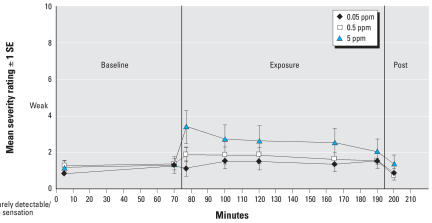
Mean anxiety symptom severity at each time point across exposure conditions. Post, postexposure. Change from 70 min to 80 min; 0.05 vs. 5 ppm: p = < 0.0001. Change from 70 min to 100 min; 0.05 vs. 5 ppm: p = 0.01. Change from 70 min to 120 min: 0.05 vs. 5 ppm; p = 0.03. Change from 70 min to 165 min: 0.05 vs. 5 ppm: p = 0.02; 0.5 vs. 5 ppm: p = 0.04. Error bars represent SE.